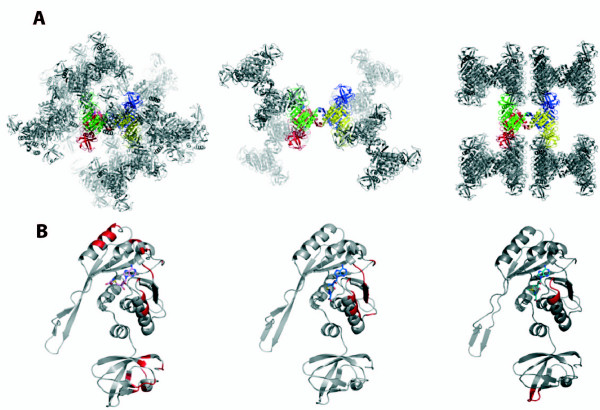
Crystallographic contacts in the various PaTrmI structures. A Different crystal packing of PaTrmI in the different crystal forms (left P212121, middle P31, right I222). B The regions involved in the crystallographic contacts are shown in red, SAH/SAM in sticks.